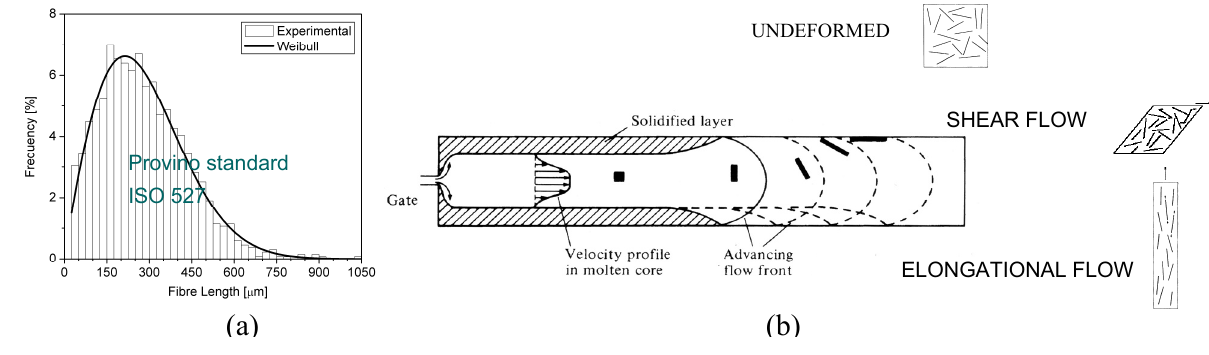
Figura 1: Distribuzione delle lunghezze [2] (a) e degli orientamenti (b) delle fibre nel processo di iniezione [5].